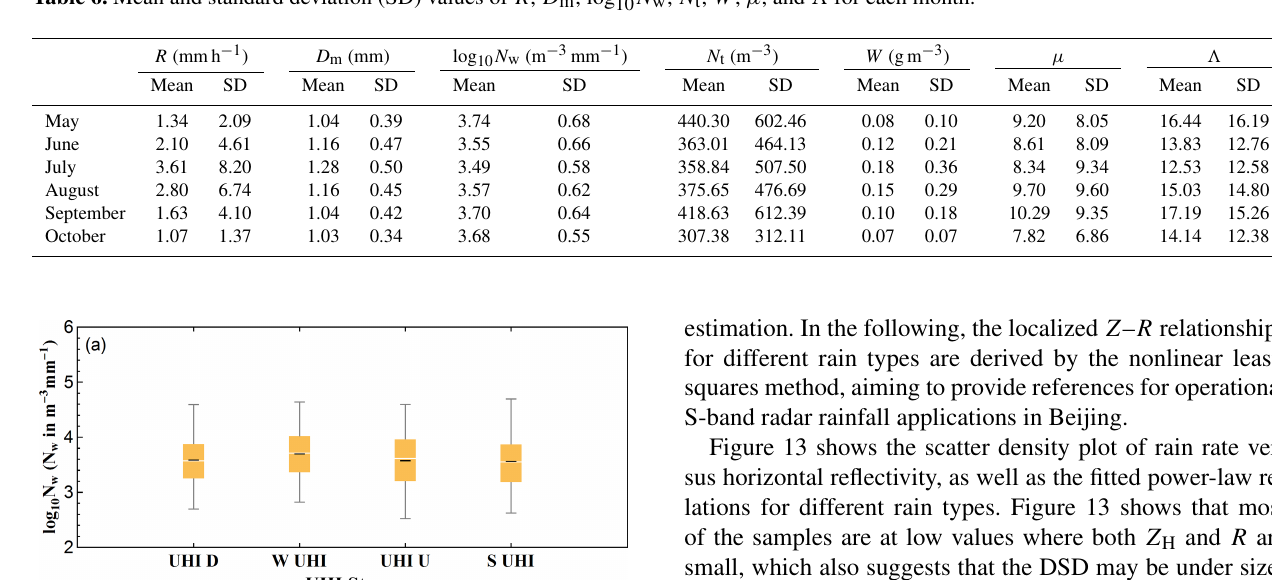
Table 6. Mean and standard deviation (SD) values of R , D m , log 10 N w , N t , W , µ , and (cid:51) for each month.